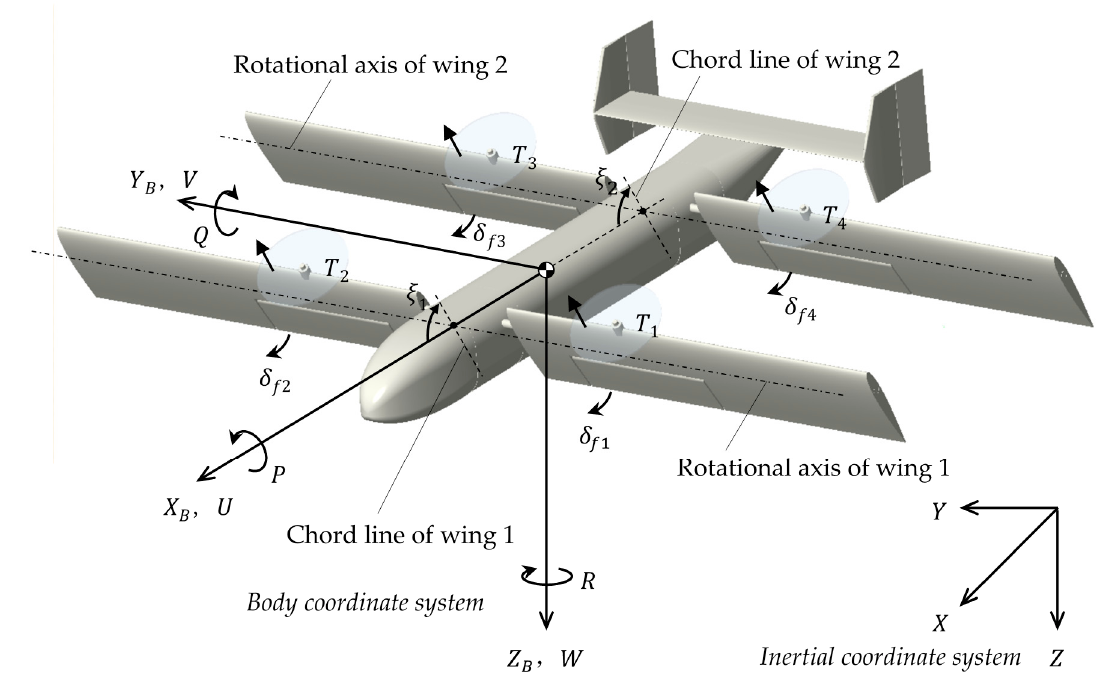
Figure 2. Definition of state variables and control inputs.